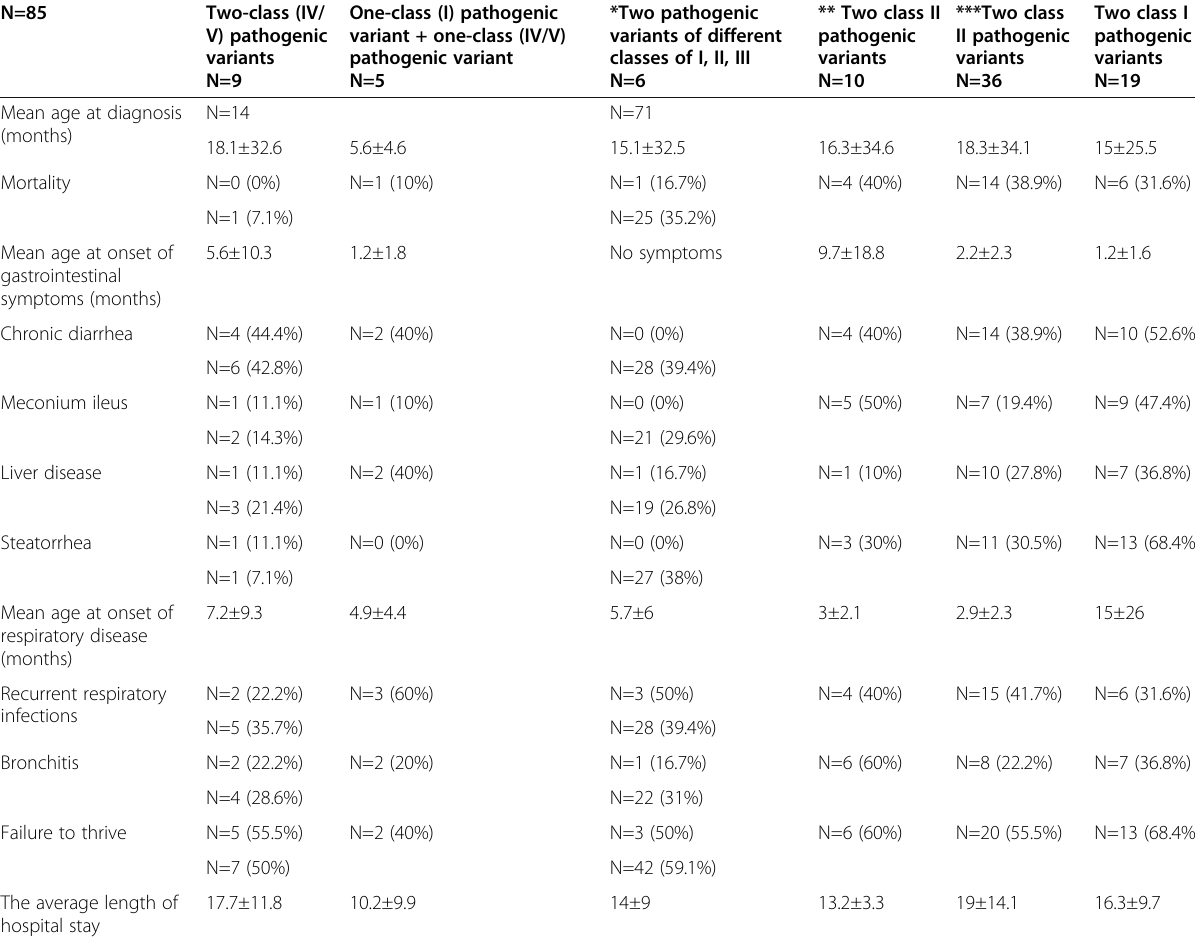
Table 6 The relationship between the pathogenic variant classes and clinical characteristics in CF patients in the studied sample